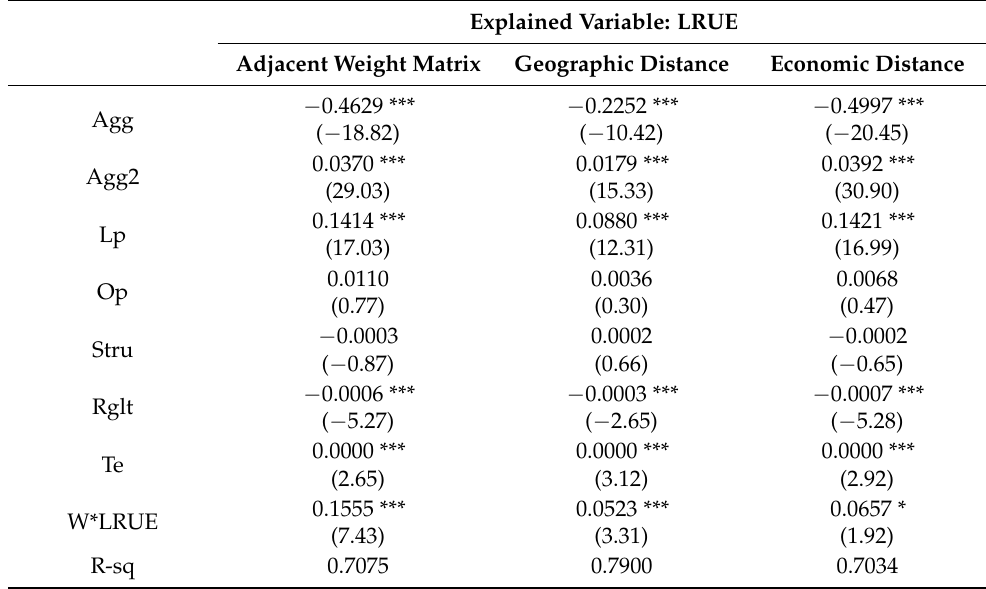
Table 4. Regression results of the spatial econometric model.